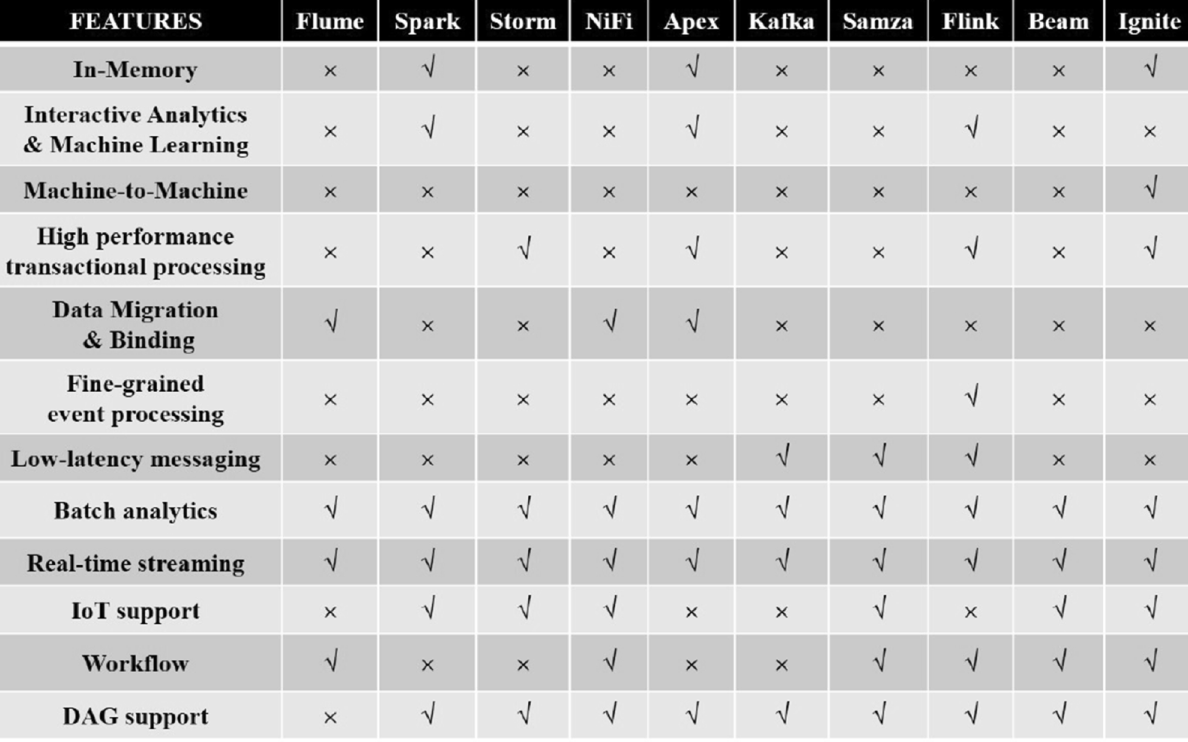
Table 1 IoT-based application attribute feature